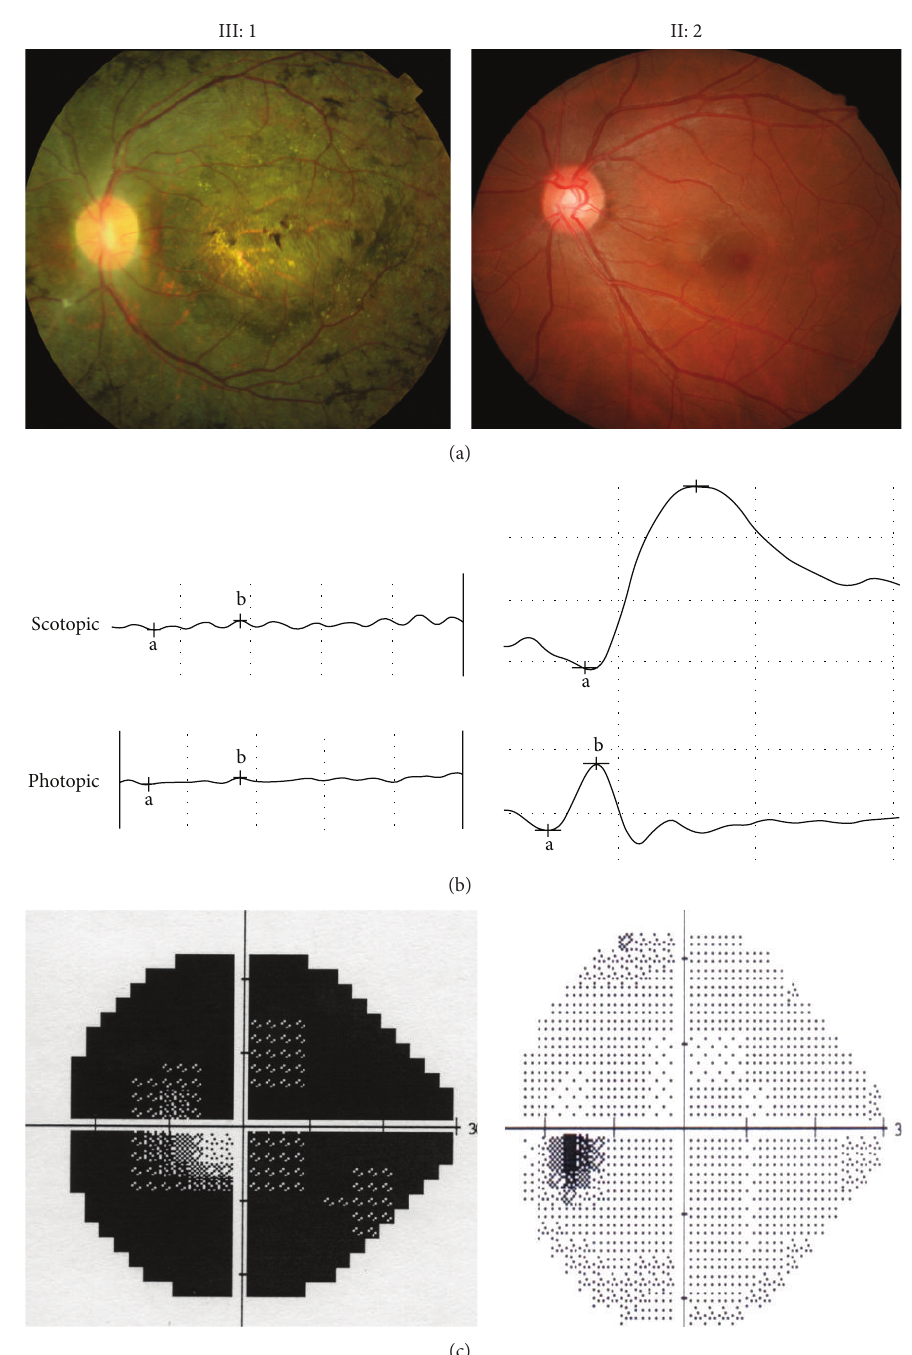
Figure 2: Representative photographs of the proband (III: 1) and one of normal individuals (II: 2) in the Chinese arRP family. (a) Compared to II: 2, the proband’s fundus photographs showed peripheral pigmentation and retinal vascular attenuation. (b) ERG records showed no detectable rod and cone responses in the proband (left), compared to the normal rod and cone responses in the normal individual (right). (c) Visual field results showed low vision in the proband, compared to the normal vision in the unaffected individual (right).